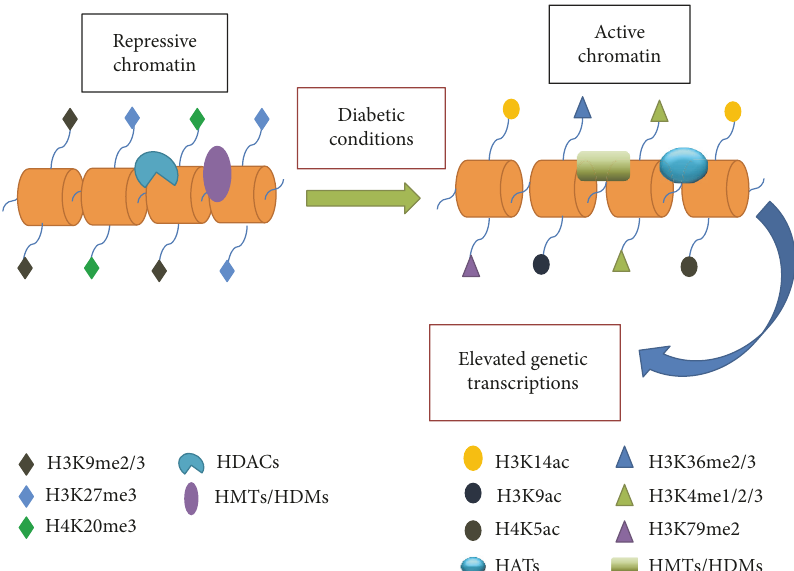
Figure 1: Histone modi fi cations stimulate the gene expressions in diabetic conditions. In normal conditions, histone deacetylases (HDACs) and histone methyltransferases (HMTs)/histone demethylases (HDMs) recruit at the gene promoters, leading to the removal of acetylation and the accumulation of repressive chromatin markers (such as H3K9me2/3, H3K27me3, and H4K20me3) at the gene promoters and inhibiting the initiation of genetic transcriptions. While in diabetic conditions, the repressive histone modi fi cations are cleared away and are replaced by the enrichment of active chromatin marks (histone acetylations and H3K36me2/3, H3K4me1/2/3, and H3K79me2), resulting in the upregulation of the expression of in fl ammatory and fi brotic genes and ultimately promoting the progress of diabetic renal complications. HDACs, histone deacetylases; HATs, histone acetyltransferase; HMTs, histone methyltransferase; HDMs, histone